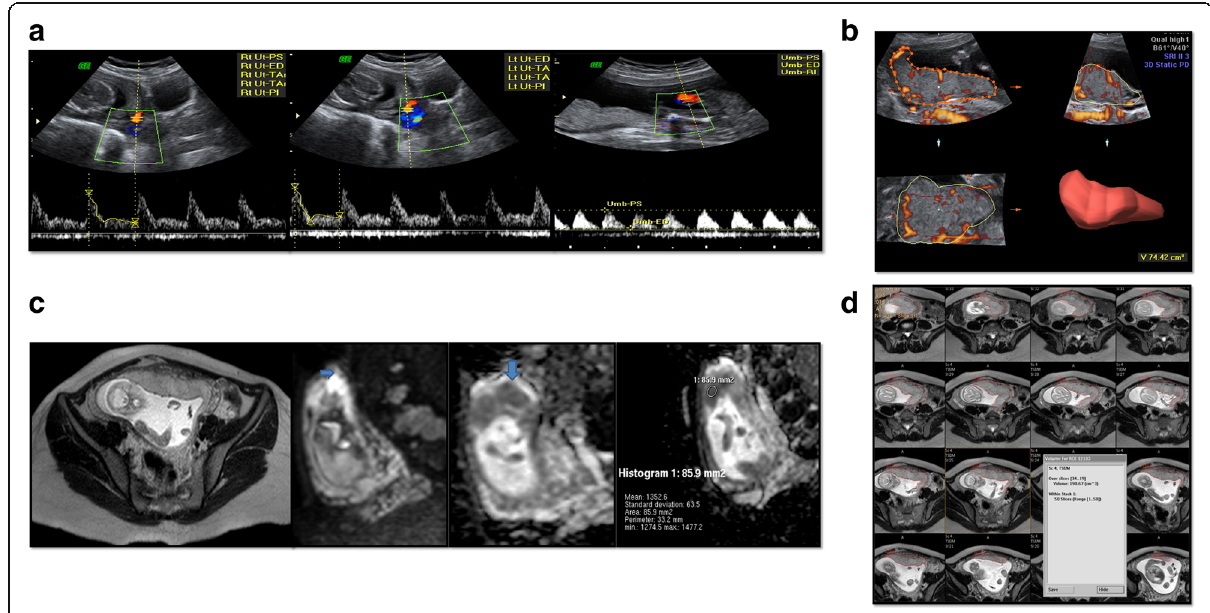
Fig. 1 Pregnant female, 18 years old. The patient has hypertension with pregnancy on Aldomet and Aspocid. Her obstetric code was G1P0. The patient did not remember her 1st day of LMP by ultrasound, and her gestational age was 22 weeks + 1day. a Doppler examination of both uterine arteries showed bilateral diastolic notches with RI of the right uterine artery 0.7 and the left uterine artery 0.69. Doppler of the umbilical artery showed RI 0.91. b 3D ultrasound measured the volume of the placenta (74.42 cm 3 ). c From the right to left, (i) axial T2-weighted image showed a heterogeneous low signal of the placenta, (ii) sagittal DWI at b 850, and (iii) ADC map: bright signal in DWI and low signal in ADC map (arrows) and low ADC value (1.35) suggestive of placental infarctions. d Placental volume measurement by MRI (190.67 cm 3 ). Comments: The patient had gestational hypertension. Both 3D ultrasound and MR showed features of placental insufficiency and small volume. The patient developed preeclampsia and had preterm